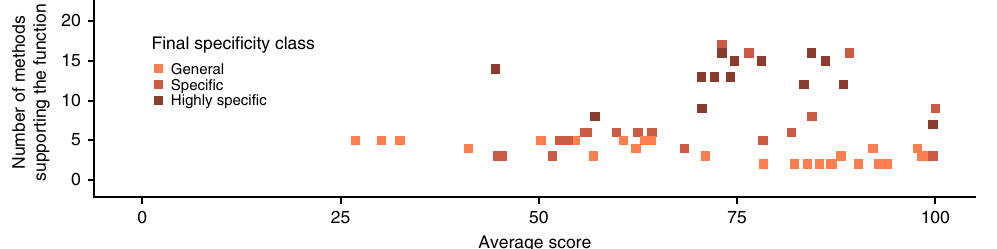
Fig. 9 Prediction of membrane related functions. Each point represents a protein with initially unknown function for which we assigned cell membrane related functions (e.g., transmembrane, transporter). The number of methods that supported the prediction is plotted against the average score from these methods. Points for each of the fi nal speci fi city classes are represented by a different colour: orange for the General speci fi city class, light brown – Speci fi c and dark brown – Highly speci fi c